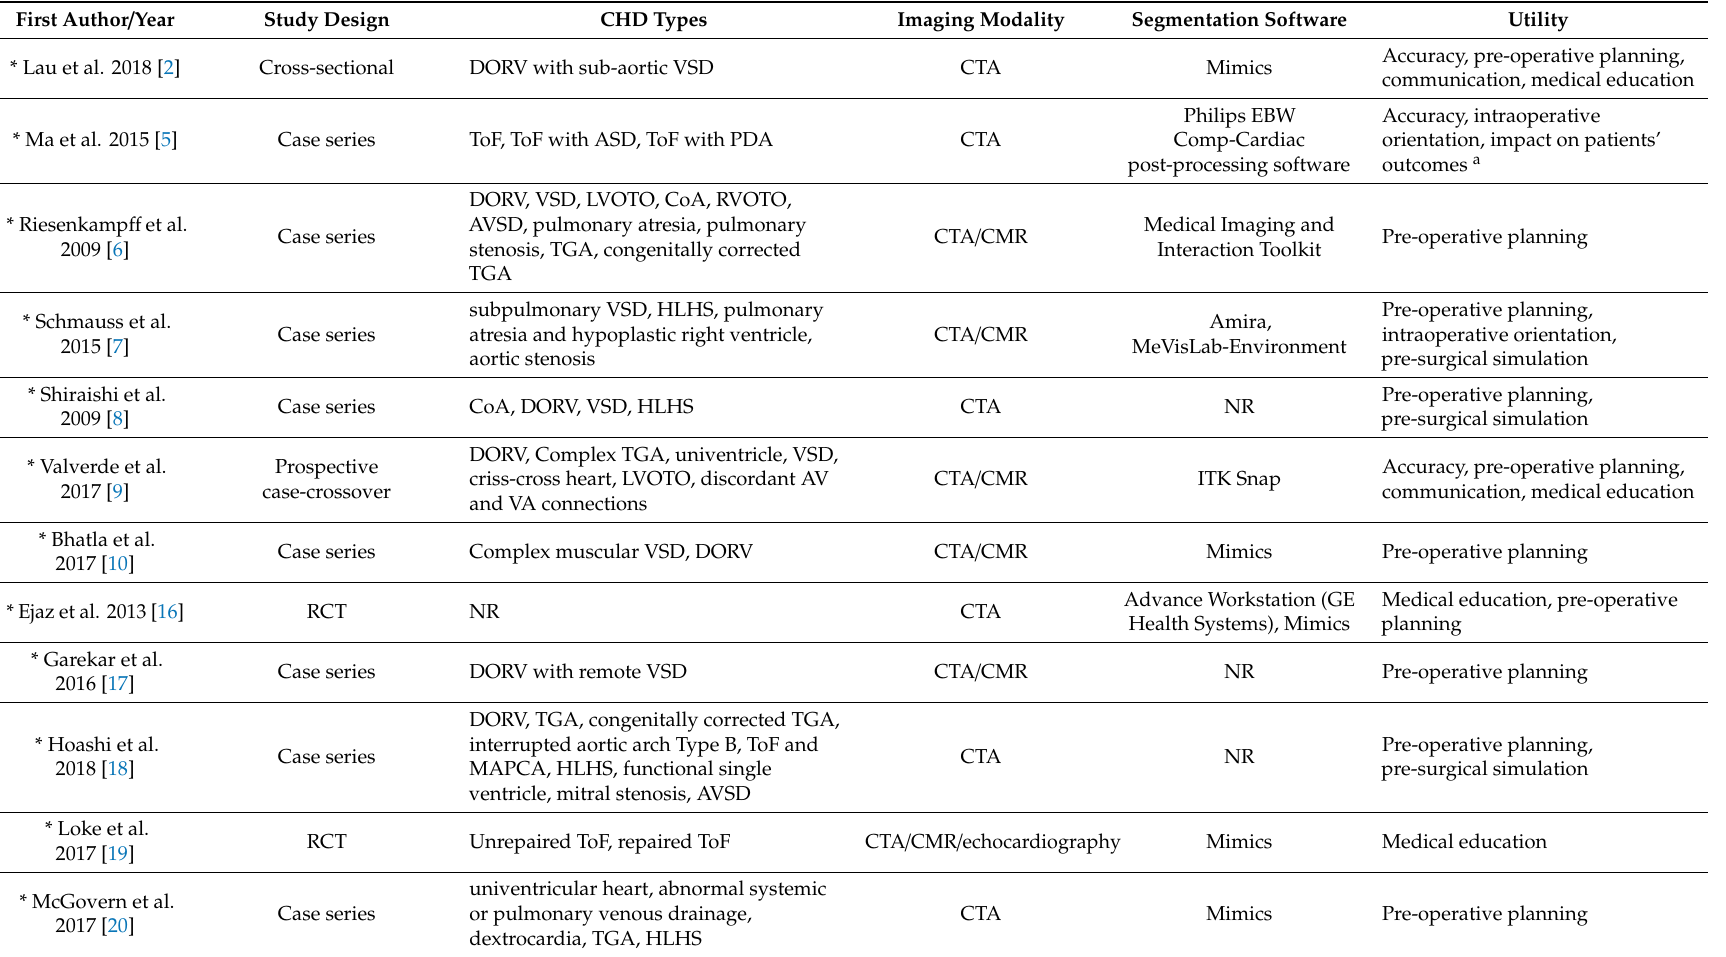
Table 1. Characteristics of the included